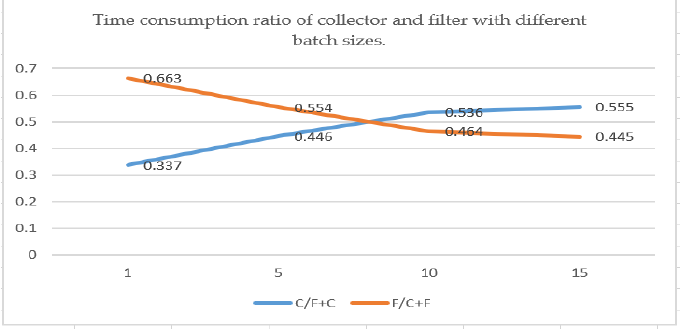
Figure 11. Time consumption ratio of collector and filter with different bundle sizes (X-axis represents batch size, Y-axis represents time consumption ratio).